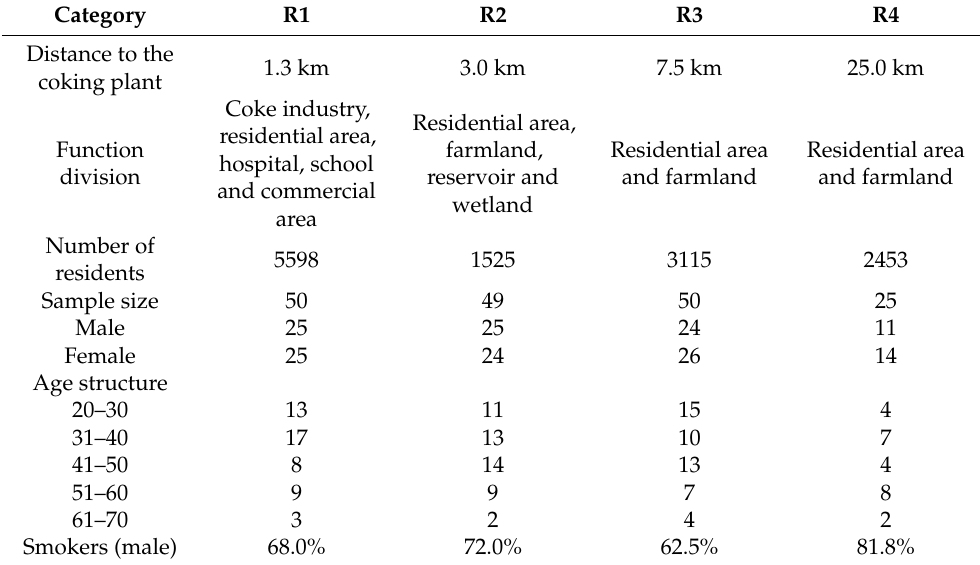
Table 1. Basic information on research